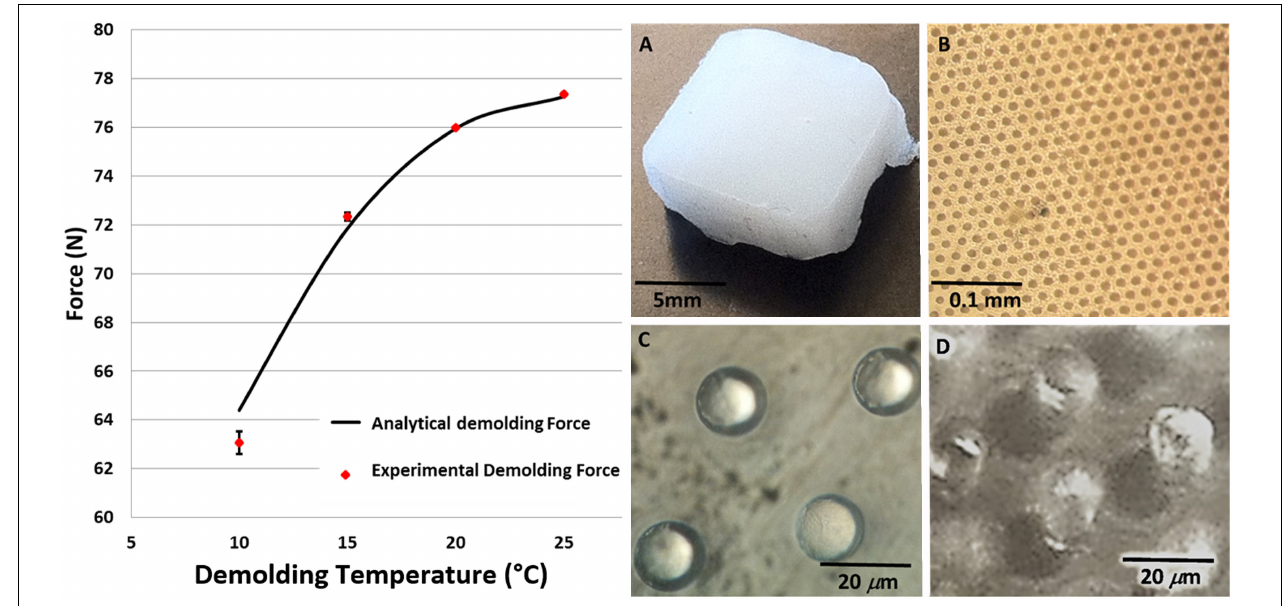
FIGURE 3 | Left panel: calculated and experimental data of the demolding force as a function of the demolding temperature ( p < 0.05). In the right panel macroscopic view of the PCL scaffolds captured by an optical microscope: (A) , low (B) and high magnification top view (C) and tilted view (D)